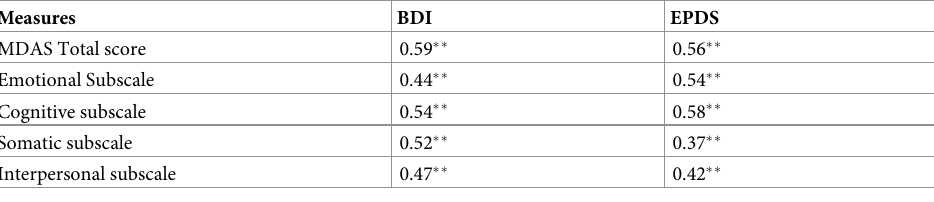
Table 3. Spearman correlation matrix of MDAS, BDI and